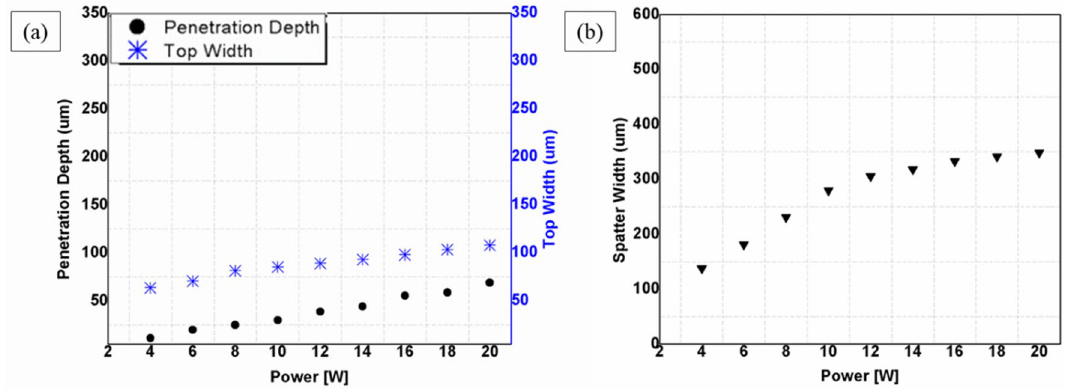
Figure 7. Effects of power; ( a ) Effect on top width and penetration depth, ( b ) Effect on spatter width [Fixed: 20 kHz, 200 ns, 100 mm/s and 1pass].